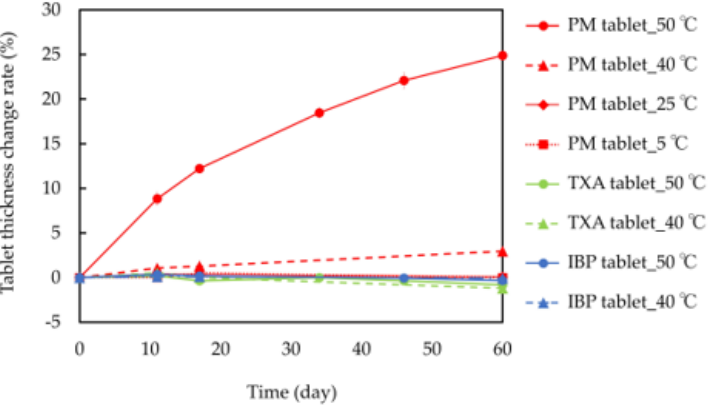
Figure 2. Tablet thickness change rates of IBP, TXA, and PM at 5 °C, 25 °C, 40 °C, and 50 °C for 60 days.